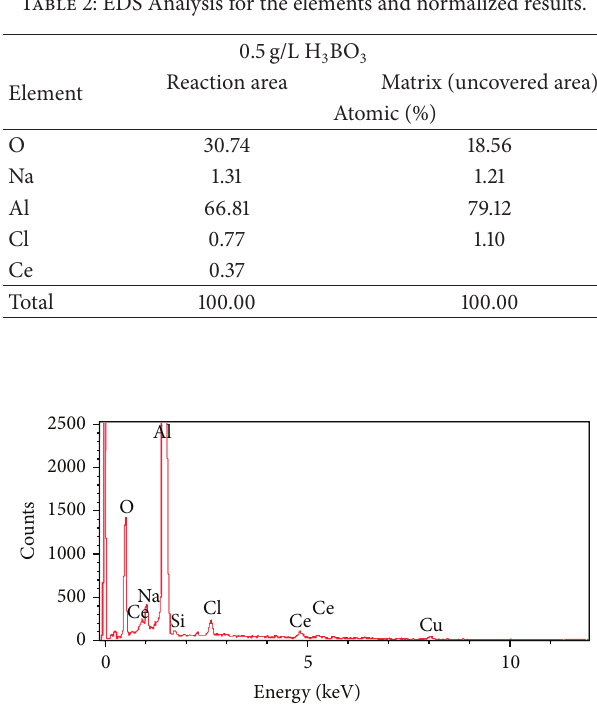
Figure 2: EDS spectra of analysis of the elements.